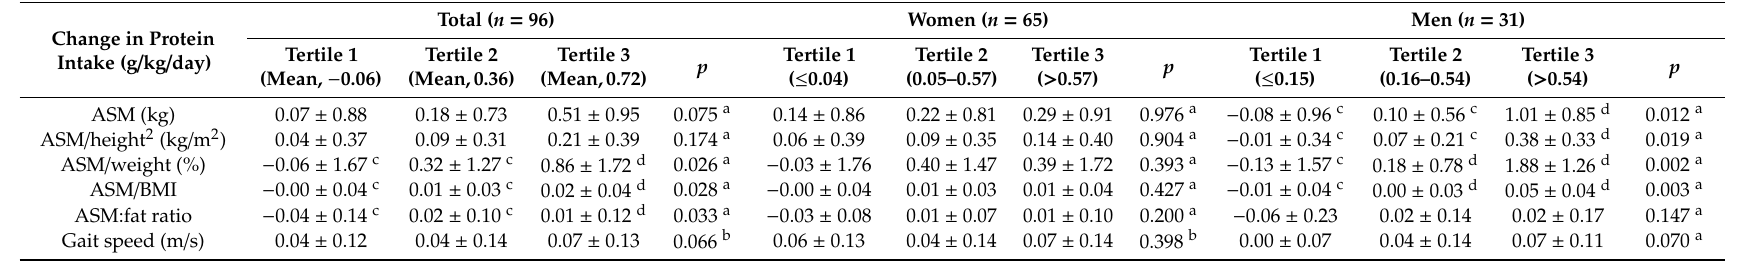
Table 2. Changes in muscle mass and gait speed according to sex-specific tertiles of change in protein intake.